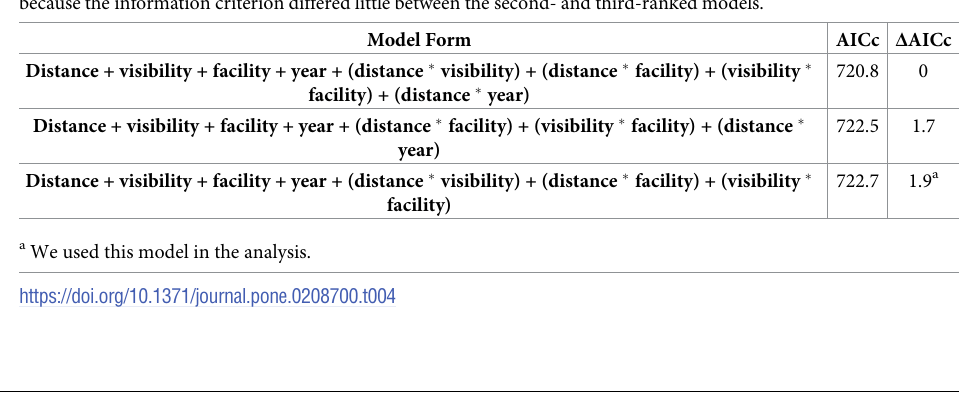
Table 11), and to 0.82 at Shiloh I (using raptors for carcass persistence trials; Table 11).